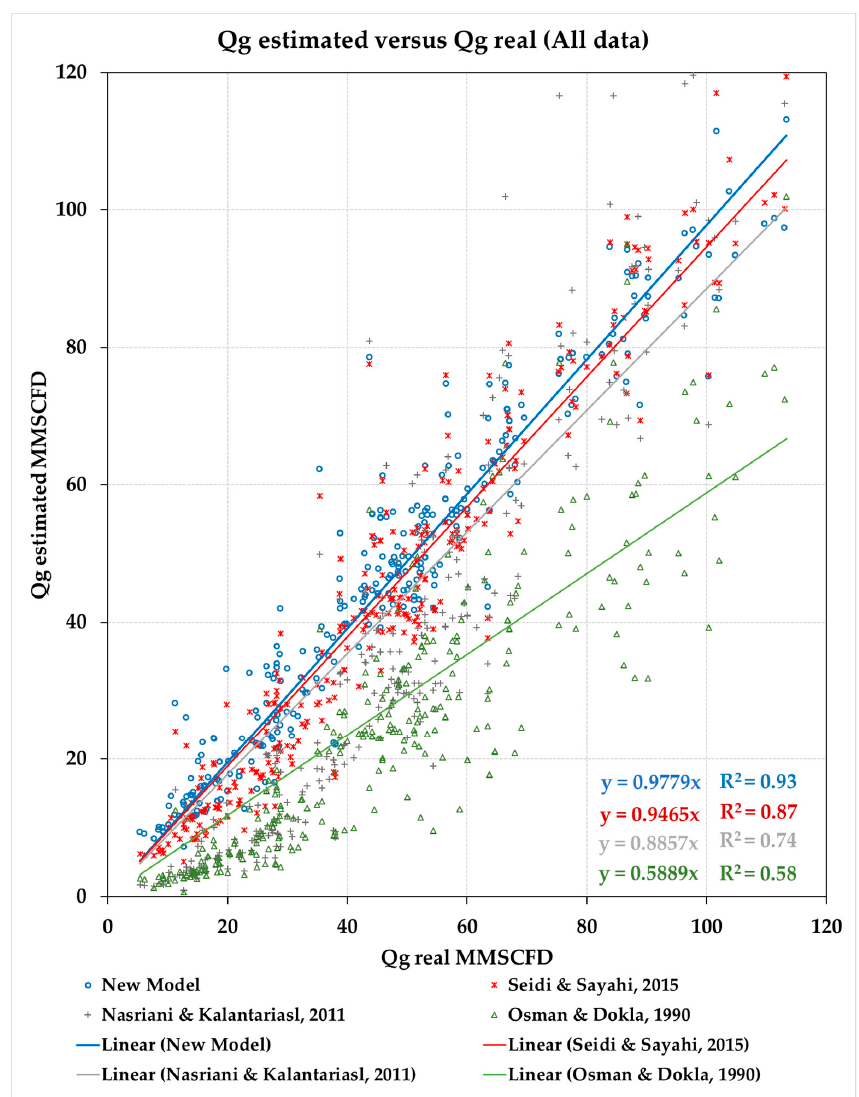
Figure 2. Estimated gas flow rate versus real gas flow rate (all data) for all four models .